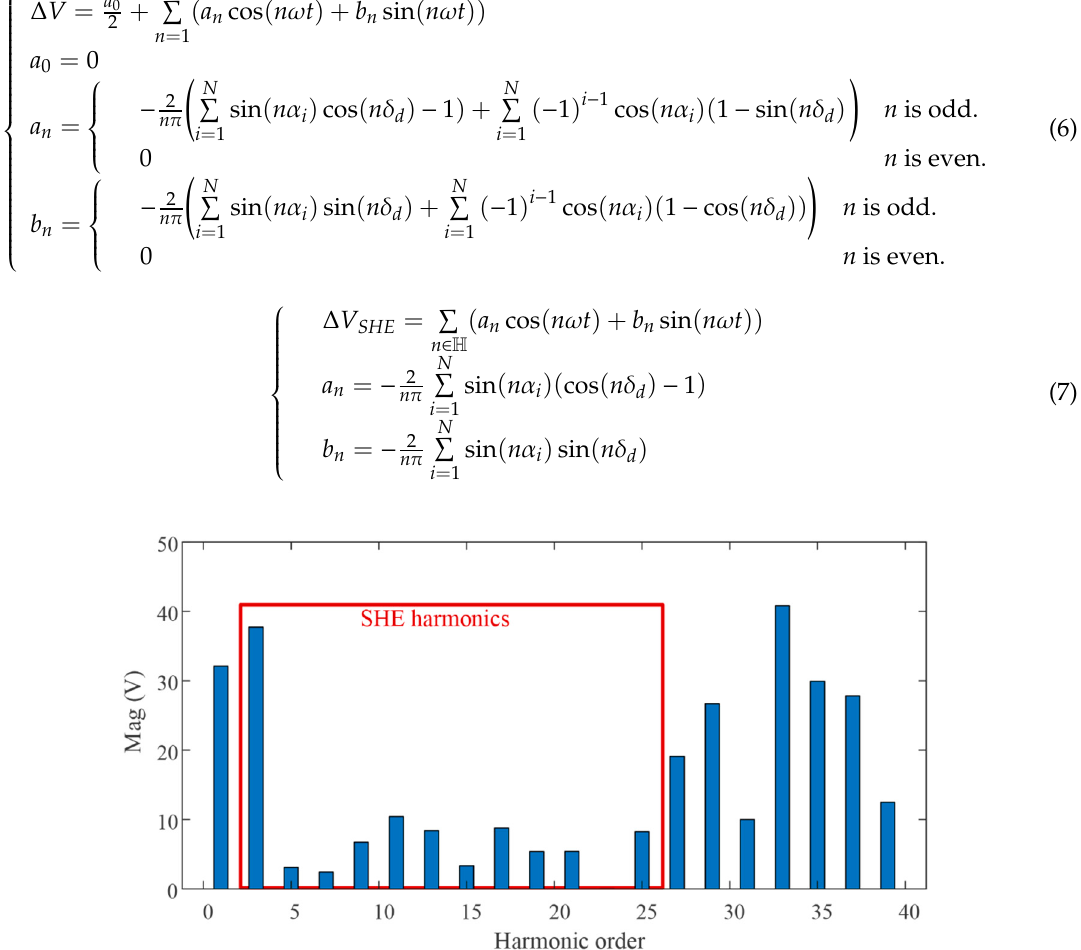
Figure 7. Output voltage error caused by dead time at quasi-unit power factor ( a ), and non-quasi-unit power factor ( b ).